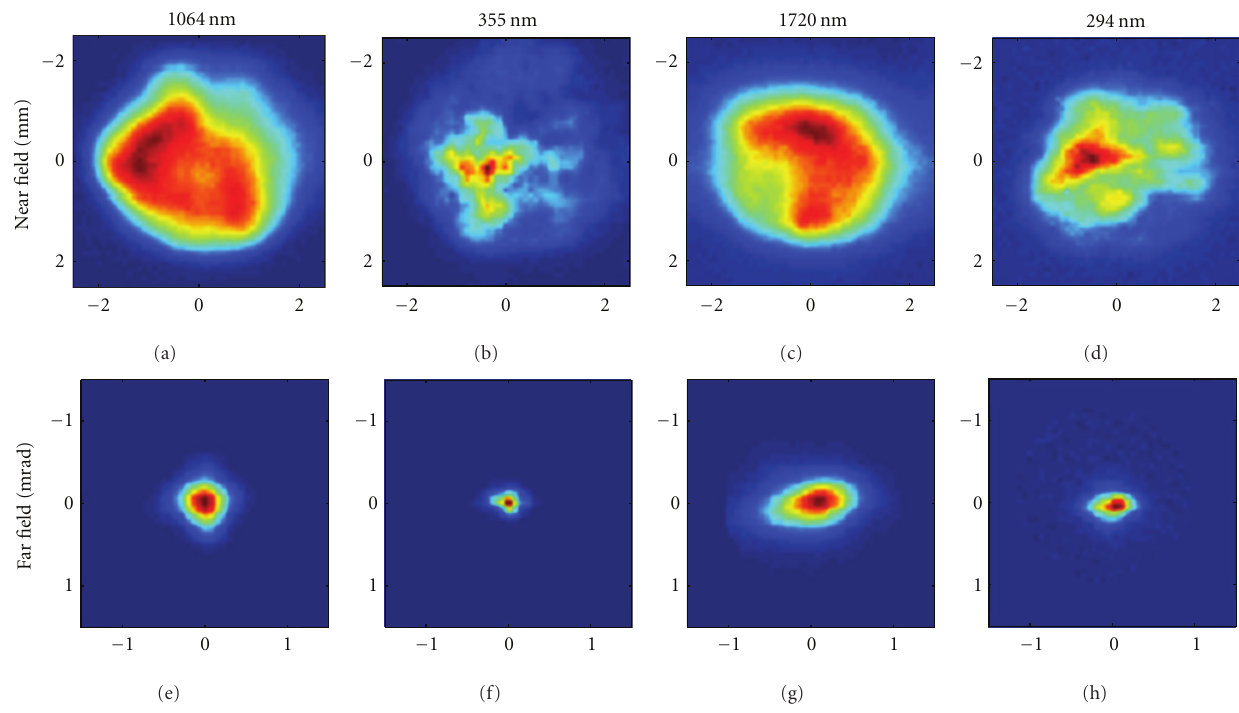
Figure 4: Near- ((a)–(d)) and far-field fluence profiles ((e)–(h)) for a single pulse of the laser fundamental, 3 ω , OPO signal, and generated UV